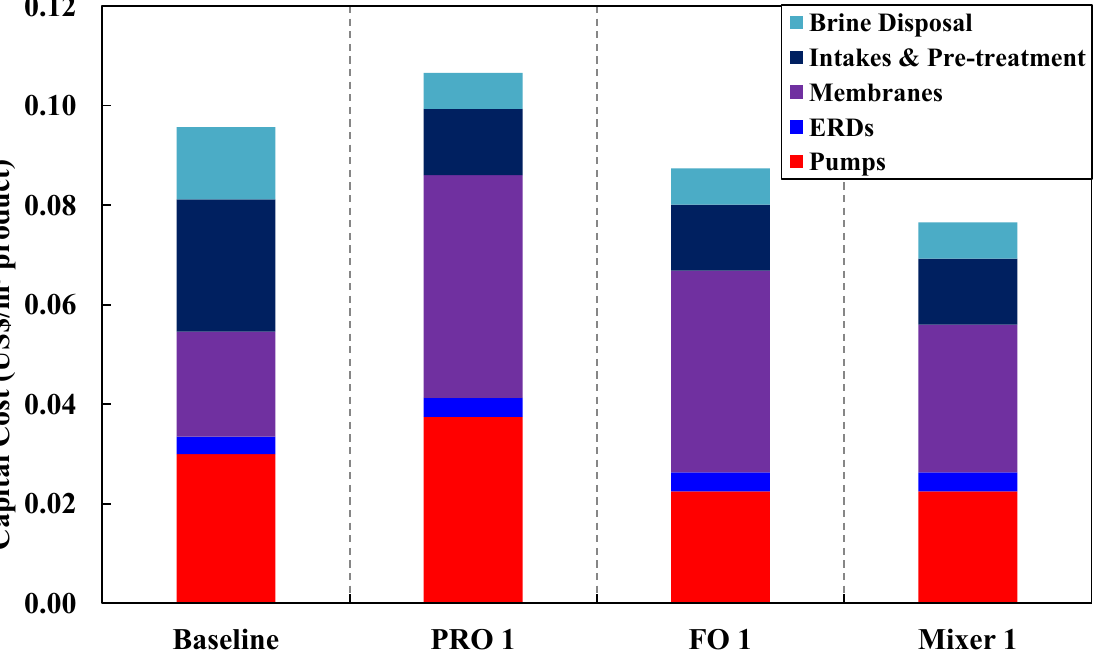
Figure 12. A summary of the space footprint considerations of the various configurations expressed as a percentage of the